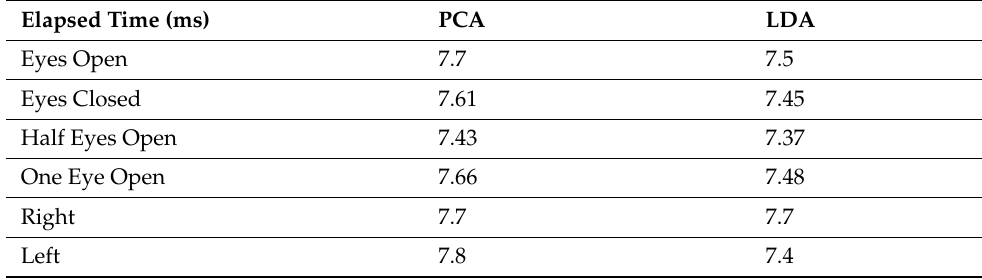
Table 5. Elapsed time to estimate the gaze direction using PCA and